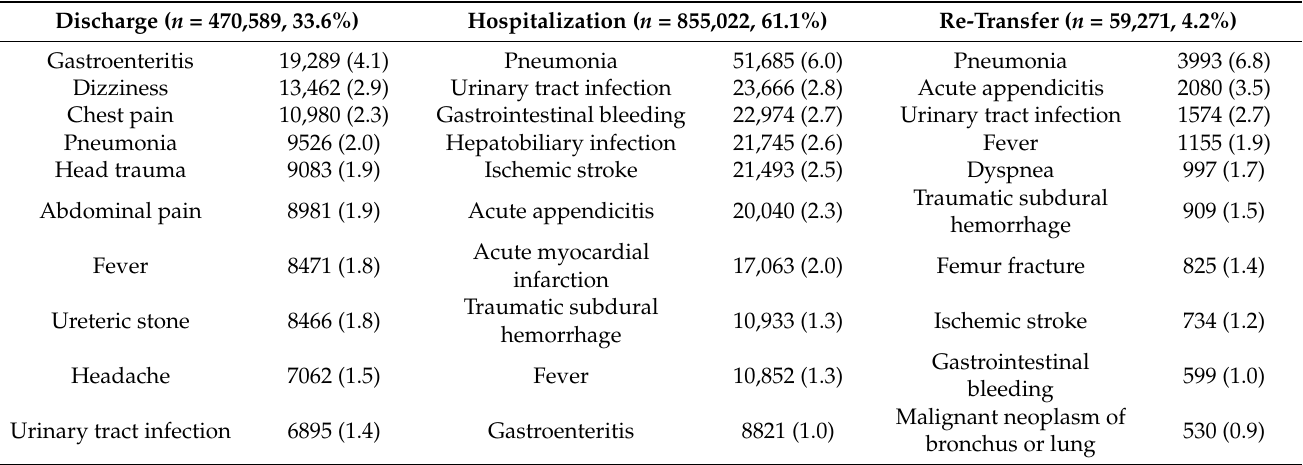
Table 4. Top 10 specific diagnoses based on patient dispositions in referred